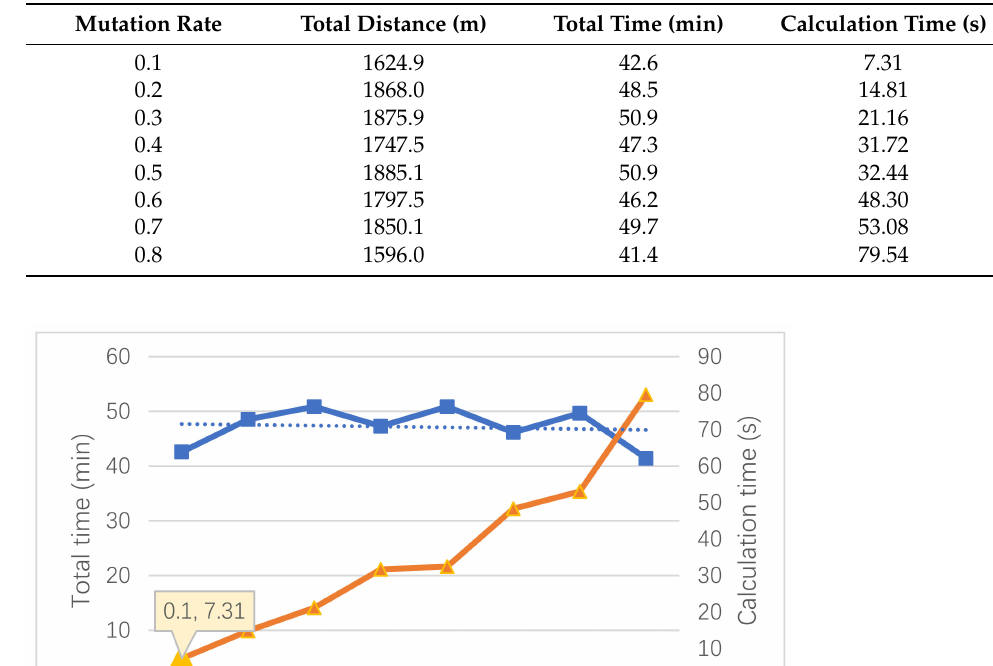
Table 2. Influence of mutation rate on GA.